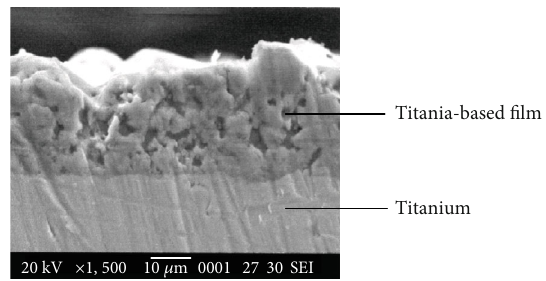
Figure 1: Cross-sectional view of the microarc oxidation